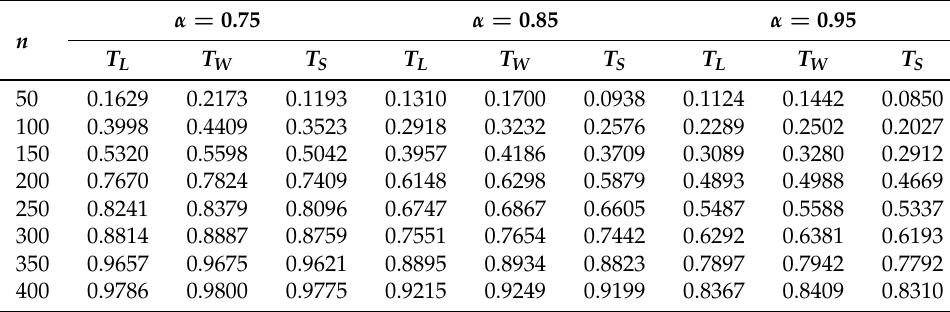
Table 6. The empirical powers of statistics ( T L , T W , T S ) for Case